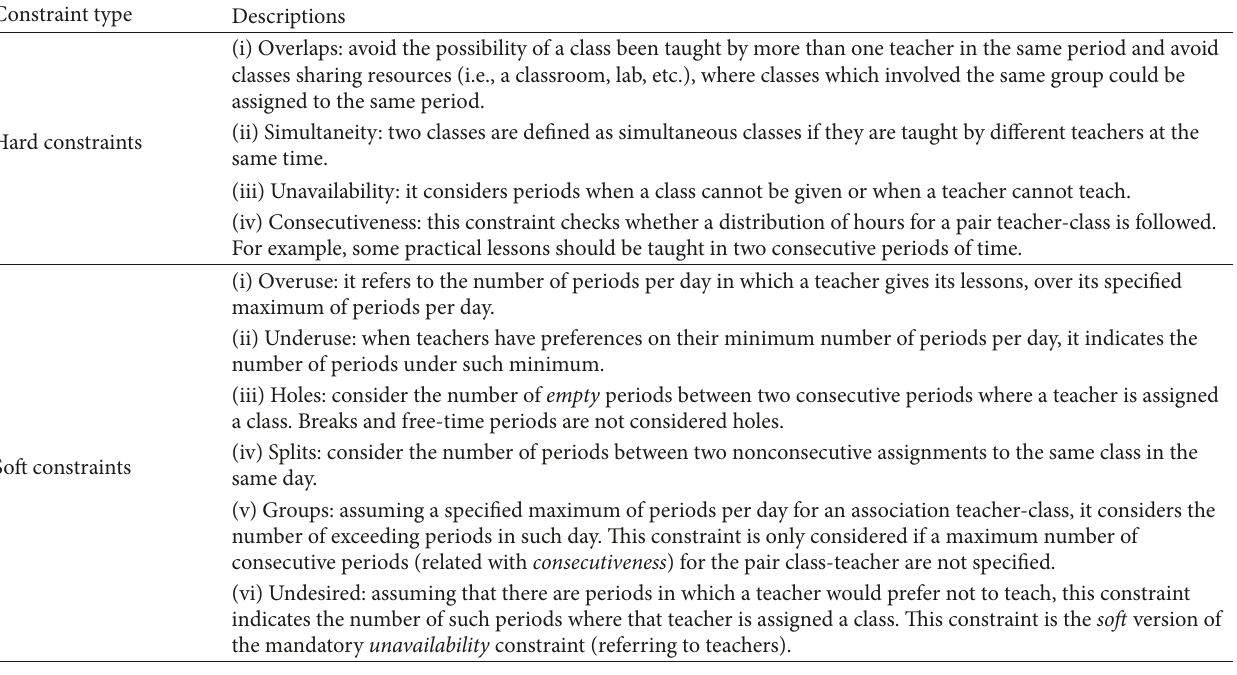
Table 7: The hard and soft constraints related to STP adopted from Cerdeira-Pena et al.